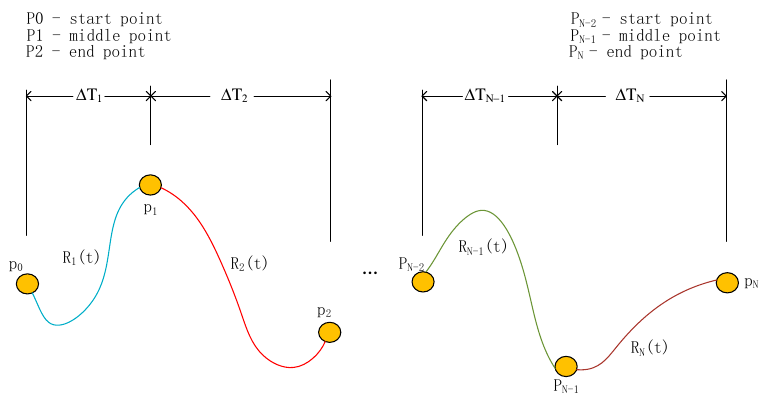
Figure 4. Schematic diagram of the continuity